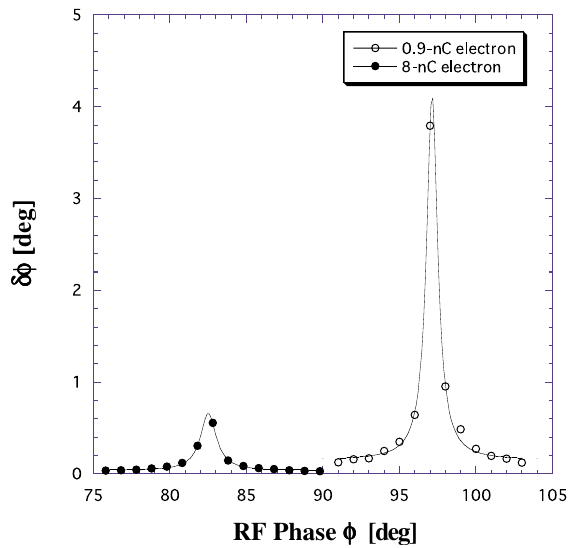
FIG. 7. (Color) Variations of the relative rf phase resolution obtained for the 0.9 and 8-nC electron beams. The solid curves drawn through the data are only to guide the